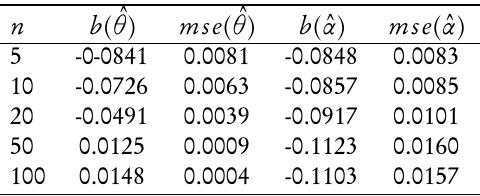
Bias and mean square error of the m.l.e.’s ( ˆ θ , ˆ α ) , for the power hypergeometric distribution {